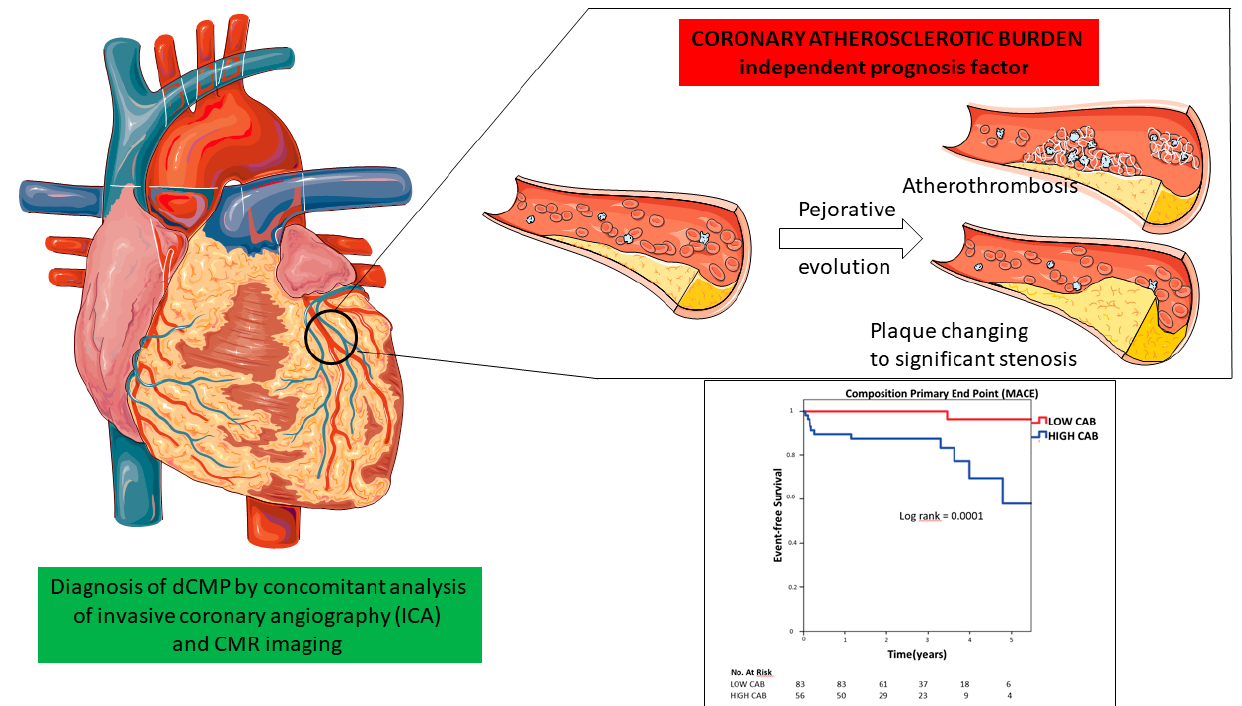
Figure 3. Kaplan–Meier event-free survival curve for the composite endpoint of cardiovascular death, non-fatal myocardial infarction (MI) or coronary artery revascularization, stratified by high or low CAB.